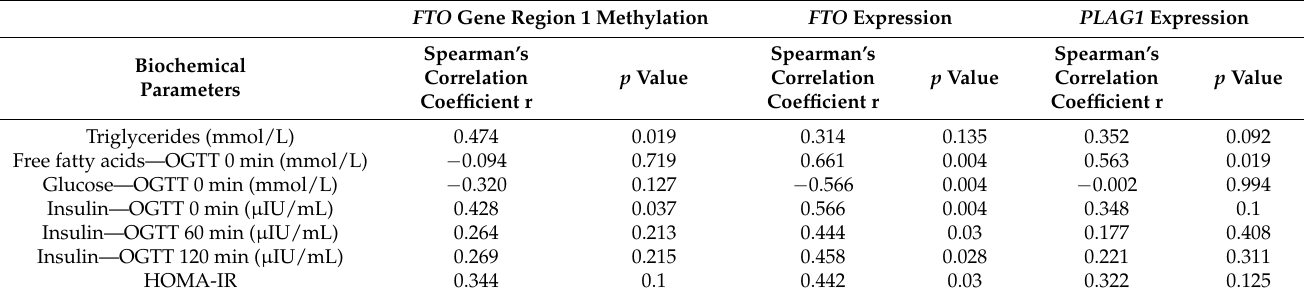
Table 4. Correlation results of biochemical parameters with FTO gene methylation, expression, and PLAG1 gene expression.